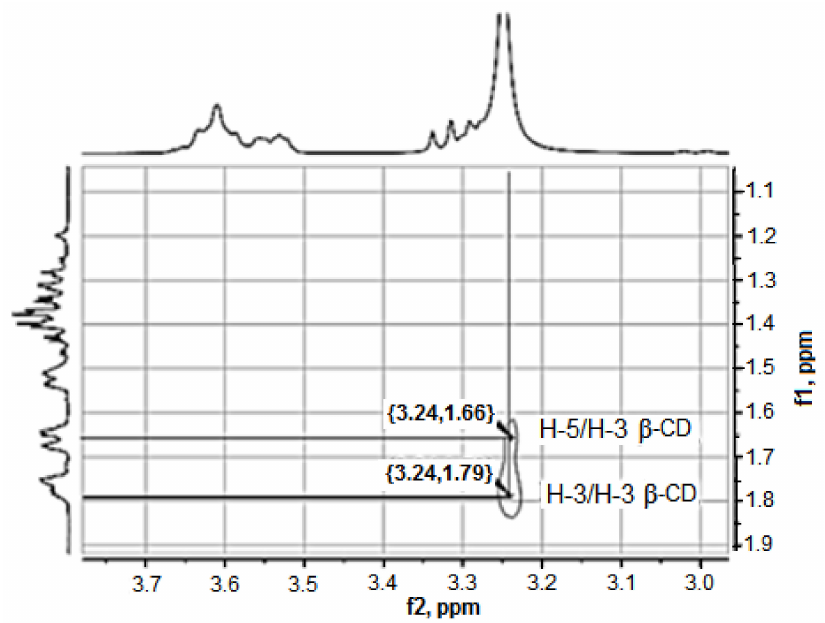
Figure 15. Fragment of the ROESY spectrum of the anabasine- β CD inclusion complex.